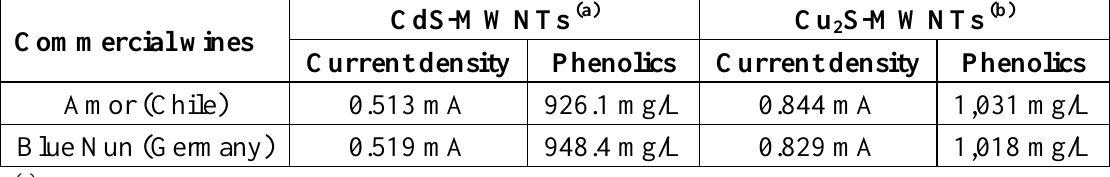
Table 2. Total amount of phenolic compounds in commercial red wines determined by the microbial sensor based on the QD-MWNT